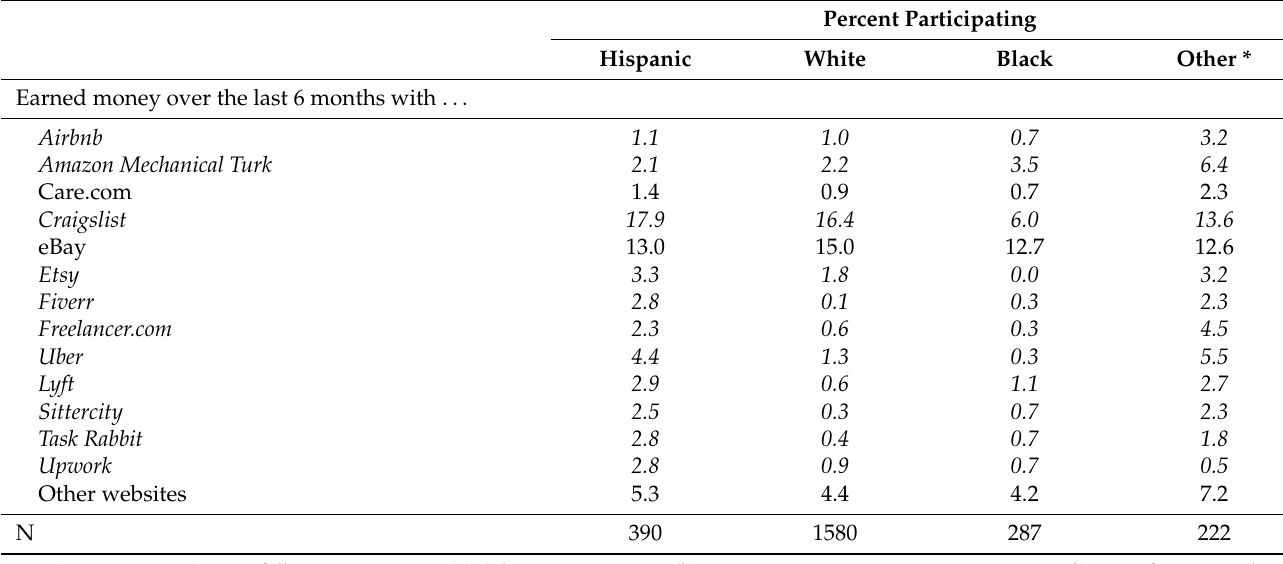
Table 5. Specific Online EIWA for Hispanics and Other Racial/Ethnic Groups. Percent Participating Hispanic White Black Other * Earned money over the last 6 months with . . .